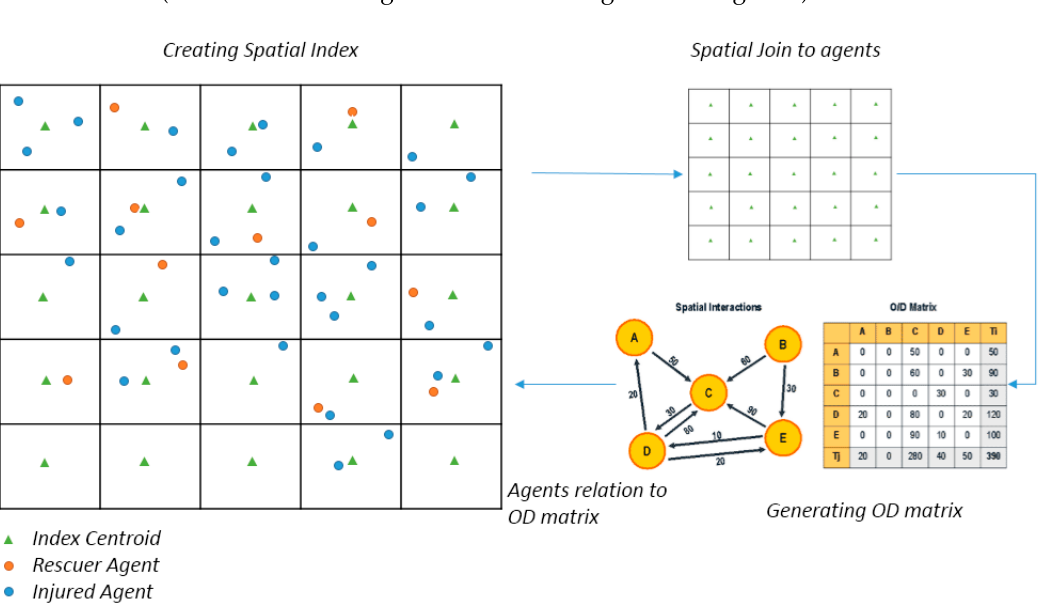
Figure 4. Rapid agents’ distance computing solution.